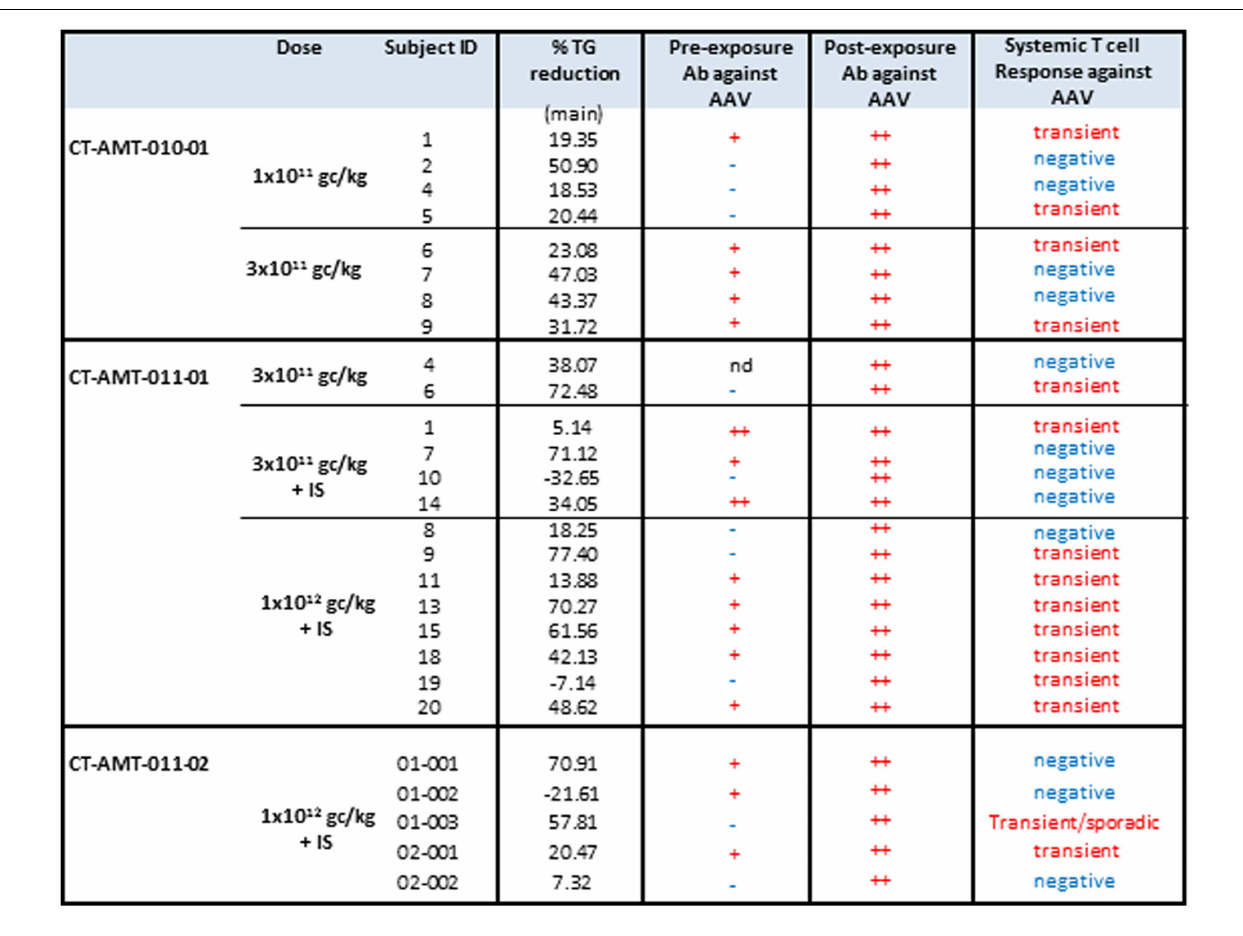
at least two consecutive sampling time points were measured positive in the ELISpot assay.The patient reported “sporadic” present recurrent non-consecutiveT-cell response over time.When none, or only one sampling time was reported positive, theT-cell response was reported negative ( −